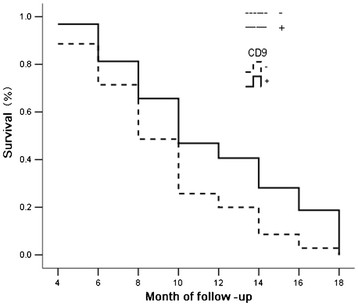
The survival curve of patients with CD9-positive or negative expression.